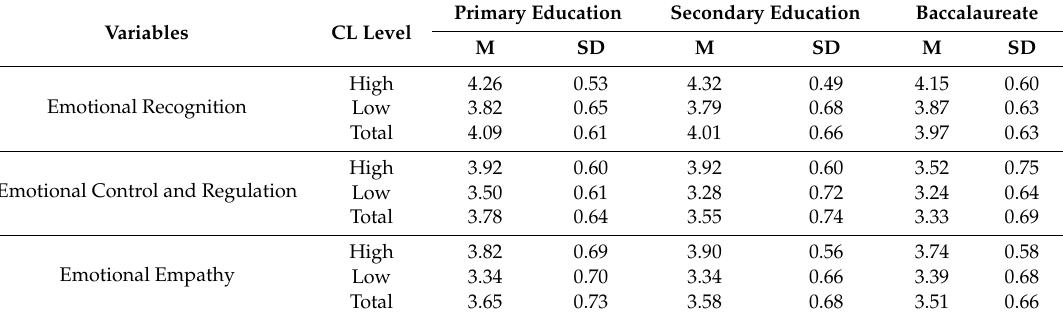
Table 4. Means and standard deviations for emotional intelligence based on cooperative learning level and educational